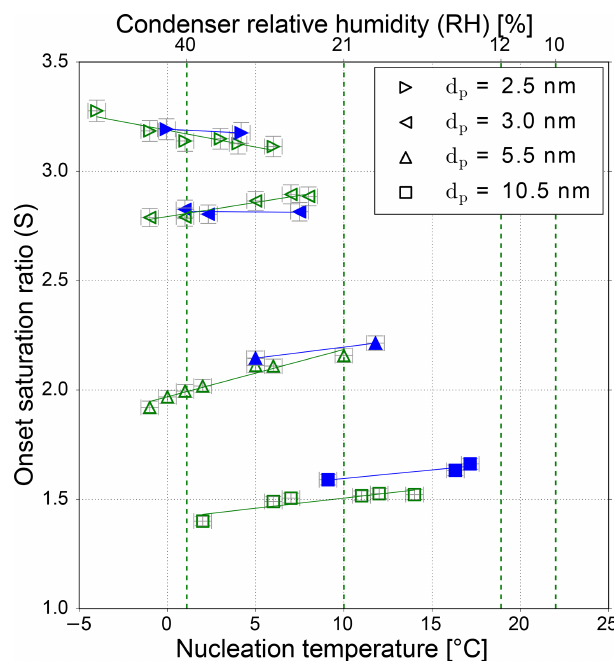
Figure 3. The onset saturation ratio versus nucleation temperature for NaCl particles of different mobility equivalent diameters. The green symbols show the onset saturation values recorded with rela- tive humidity values ≤ 10%, and the blue symbols represent mea- surement values when the RH was < 3 . 5%. The green dashed ver- tical lines represent the calculated relative humidities at the corre- sponding preset condenser temperature (see Table 1) with a starting value of 10%RH at 22 ◦ C. The increased relative humidity inside the condenser of a TSI 3776 UCPC for reduced nucleation tem- peratures is shown and will be discussed in the counting efficiency measurements